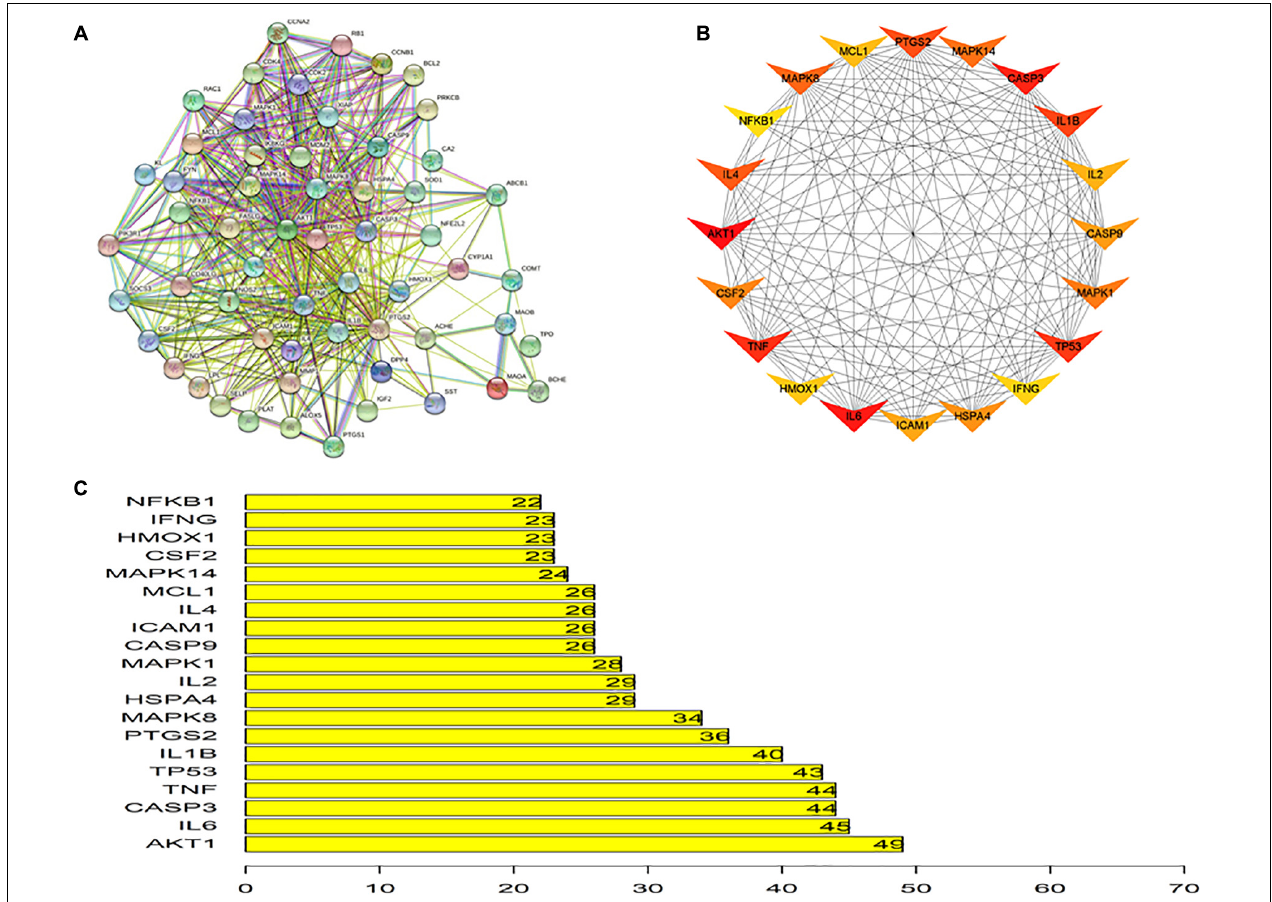
FIGURE 5 | Protein-protein interaction network. (A) Protein-protein interaction network of putative targets of EJSW against ITP. (B) Top 20 of related targets. (C) The rank of top 20 related